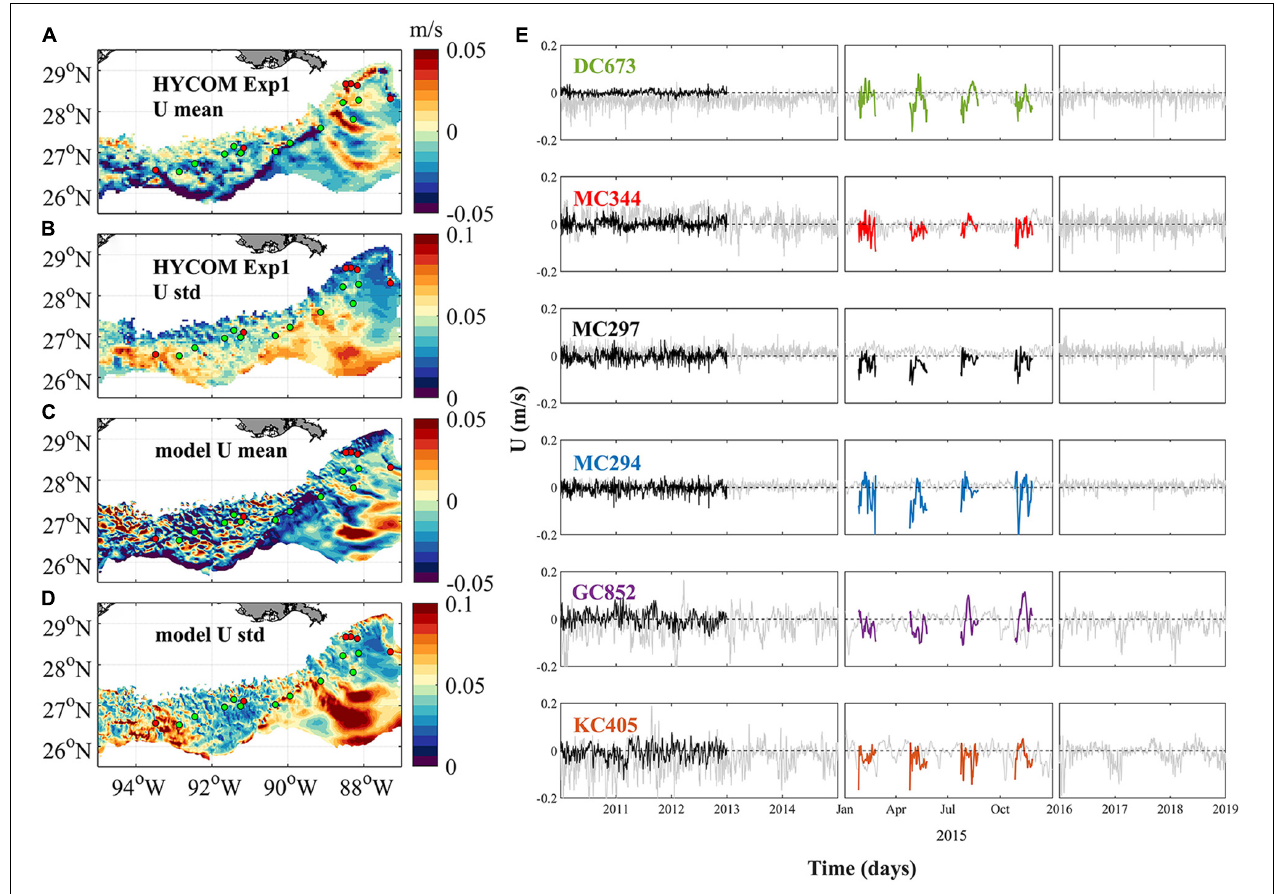
FIGURE 2 | Near-bottom circulation in the northern GoM between 1,000 and 3,000 m. (A) Averaged hourly HYCOM Exp1 zonal current (west–east) from 2010 to 2018, (B) the corresponding standard deviation (std), (C) daily averaged model zonal current, dataset is collected from February, May, August, and November 2015 with a time period of 30 days for each simulation, and (D) the std of the modeled zonal current. The six sampling sites are colored by red dots, while the intermediate sites are shown in green. Panel (E) shows the near-bottom zonal current at each sampling location during the period of 2010–2014 (left), 2015 (middle), and 2016–2018 (right). Gray, black, and color lines indicate result of HYCOM Exp1, HYCOM Exp2, and CROCO, respectively. Positive values indicate an eastward current, and negative values